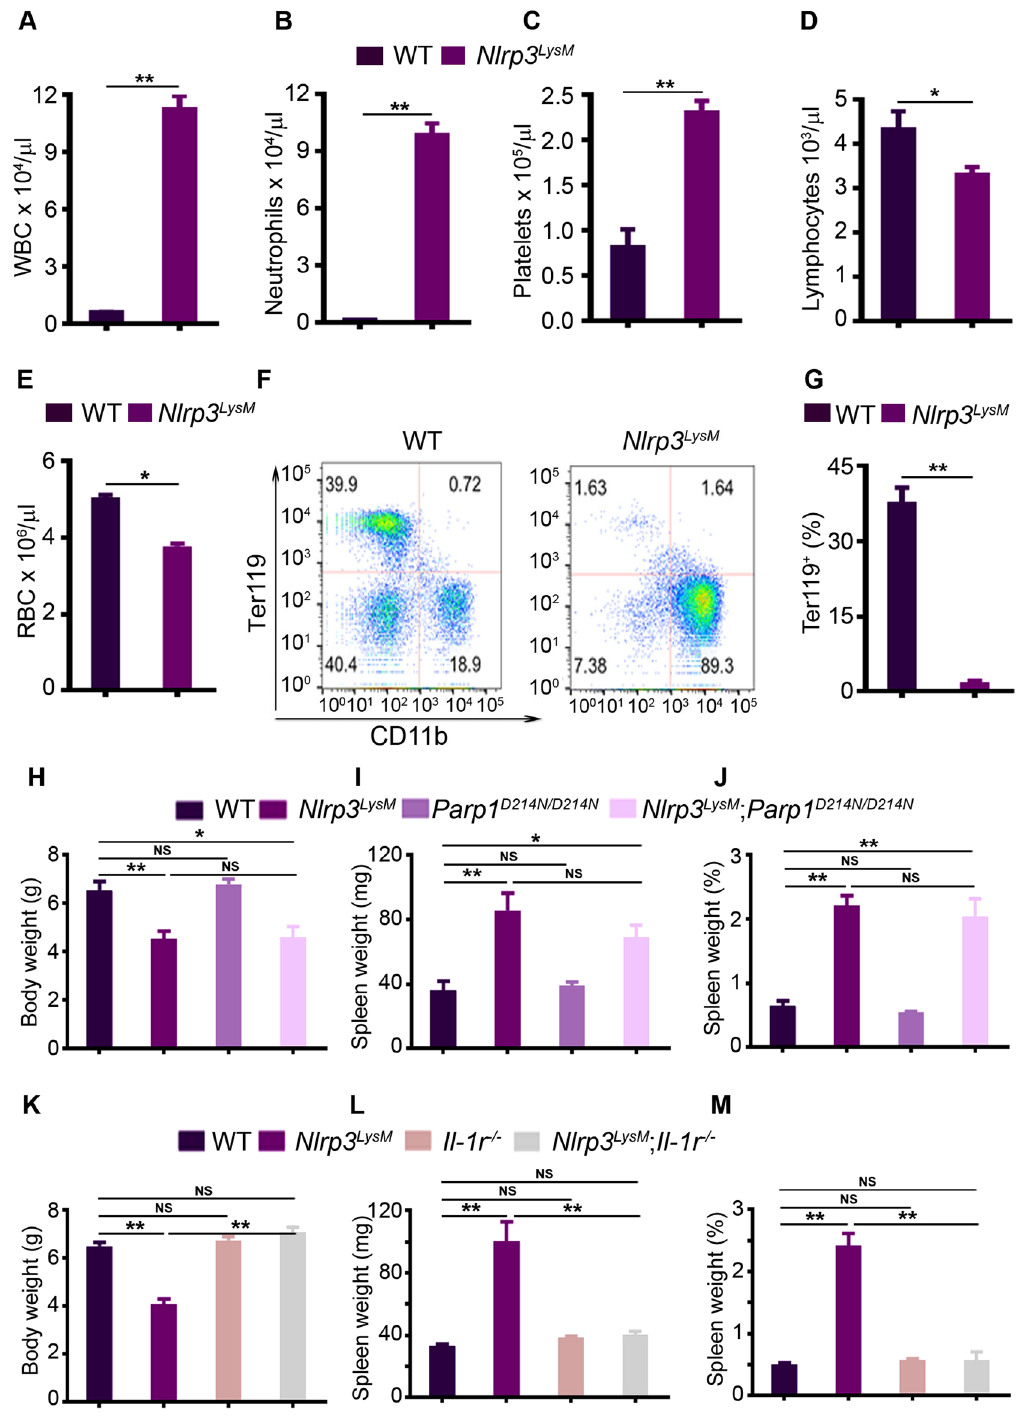
Figure 4. Constitutive activation of the NLRP3 inflammasome in myeloid cells causes anemia of inflammation through IL-1 signaling. All data were obtained from 2-week old WT or mutant male mice. ( A – E ) Cell blood counts (n = 4 mice/genotype). WBC, white blood cell counts, RBC, red blood cell counts. ( F ) Bone marrow cells (n = 4 mice/genotype) were stained with isotype control (data not shown) or with antibodies against CD11b and Ter119. Representative flow cytometry dot plots of CD11b + myeloid cells or Ter119 + erythrocytes from each genotype are shown. ( G ) The percentage of Ter119 + erythrocytes in bone marrow cells. Data are expressed as mean ± SEM. * P < 0.05; ** P < 0.005. ( H ) Body weight. ( I ) Spleen weight. ( J ) Percent of spleen weight (spleen weight was normalized to body weight). Quantitative data ( H – J ) were obtained from 5–6 mice/genotype and expressed as the mean ± SEM. * P < 0.05; ** P < 0.005. ( K ) Body weight. ( L ) Spleen weight. ( M ) Percent of spleen weight. Quantitative data ( K – M ) were obtained from 3–5 mice/genotype and expressed as the mean ± SEM. ** P < 0.005. NS, not